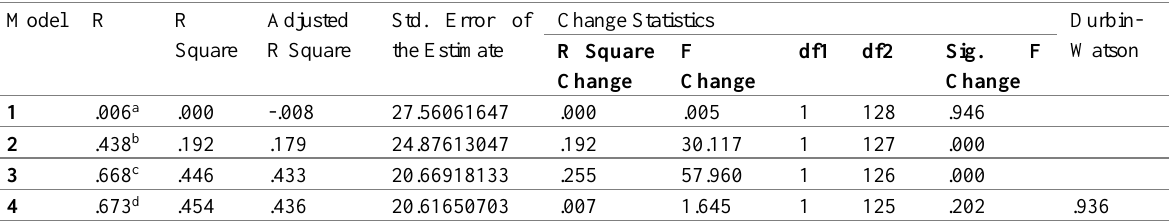
Table 8: Model Summary e (time, bank, internal equity and bank